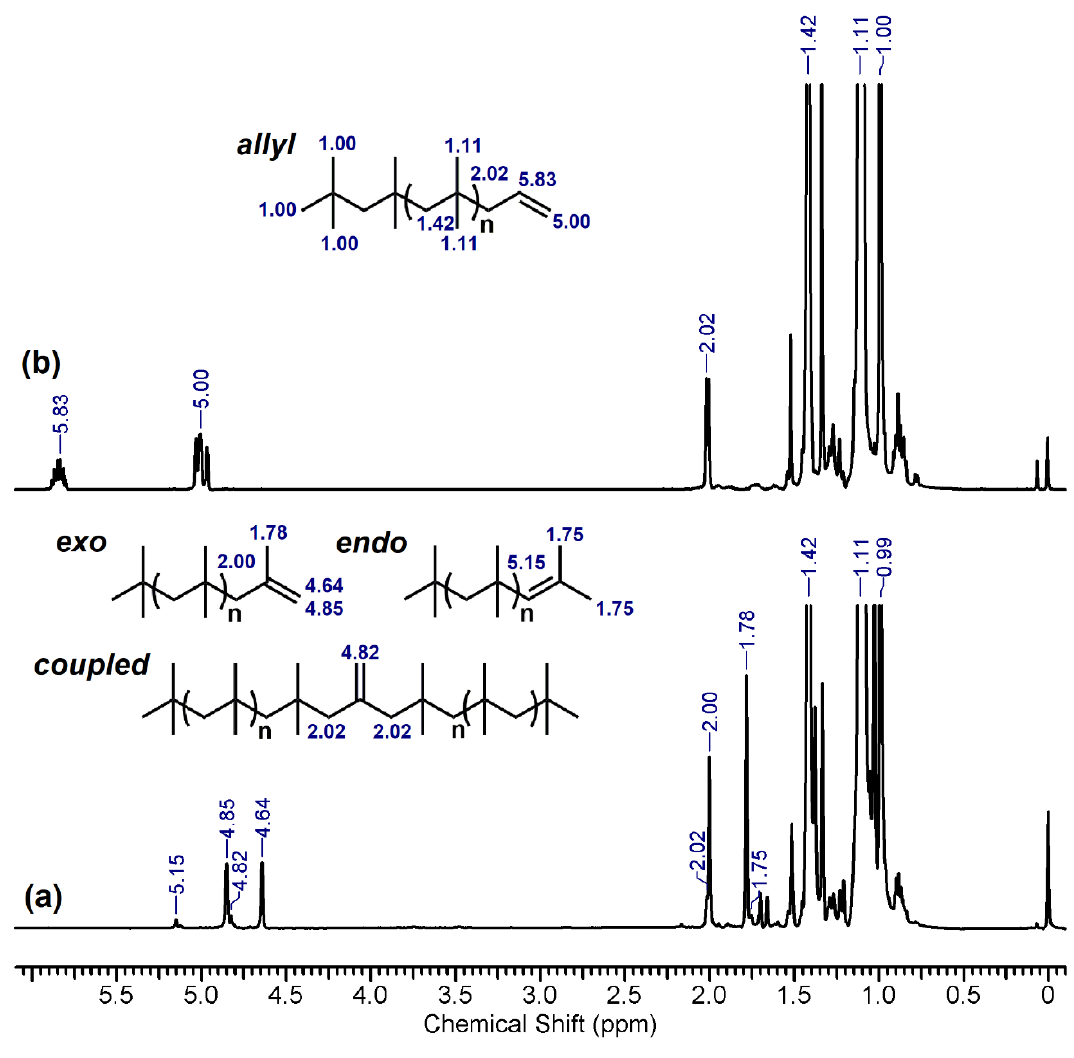
Figure 1. 1 H NMR spectra of the exo-olefin-ended ( a ) and allyl-terminated polyisobutylene ( b ). Table 1. The e ff ect of the reaction conditions on the tosylation of PIB exo -OH at room